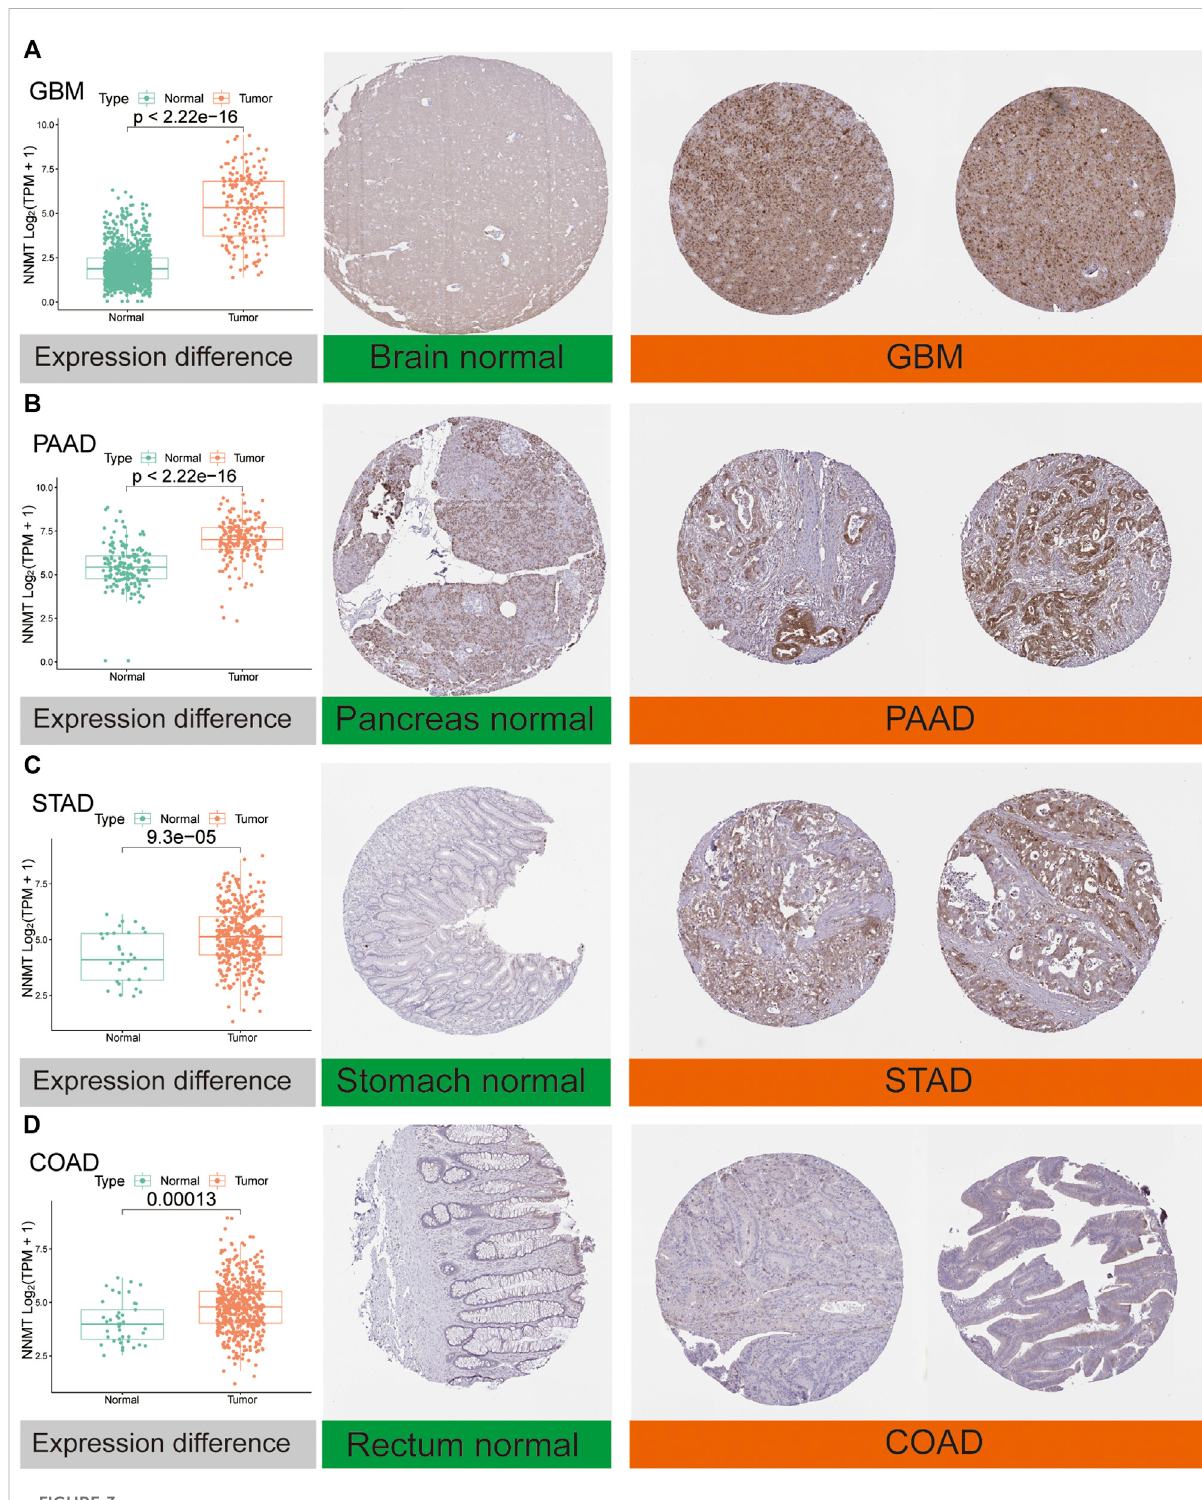
FIGURE 3 ComparisonofNNMTexpressionatthemRNAlevel(left)andproteinlevel(middleandright).ImmunohistochemicalimagesshowedthatNNMT proteinwashigher inGBM,PAAD,STAD,COAD, andKIRC,whileitwaslowerinLUADandLIHC comparedwith normaltissue. (A) Brain. (B) Pancreas. (C) Stomach. (D) Rectum. (E) Kidney. (F) Lung. (G)